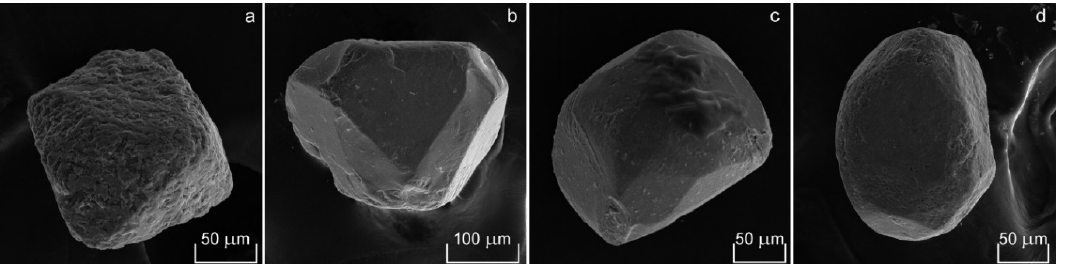
Figure 12. Morphology of chromian spinel grains from the Novomikhaylovka paleoplacer (SE images): ( a )—corroded octahedron (group I), ( b )—segment of the octahedron (tritetrahedron-shaped crystal with vicinals) (group III), ( c )—distorted cuboctahedron-shaped crystal complicated by dodecahedron facets (group III), ( d )—distorted octahedral rhombohedron-shaped crystal with pyramidal facets (group IV).